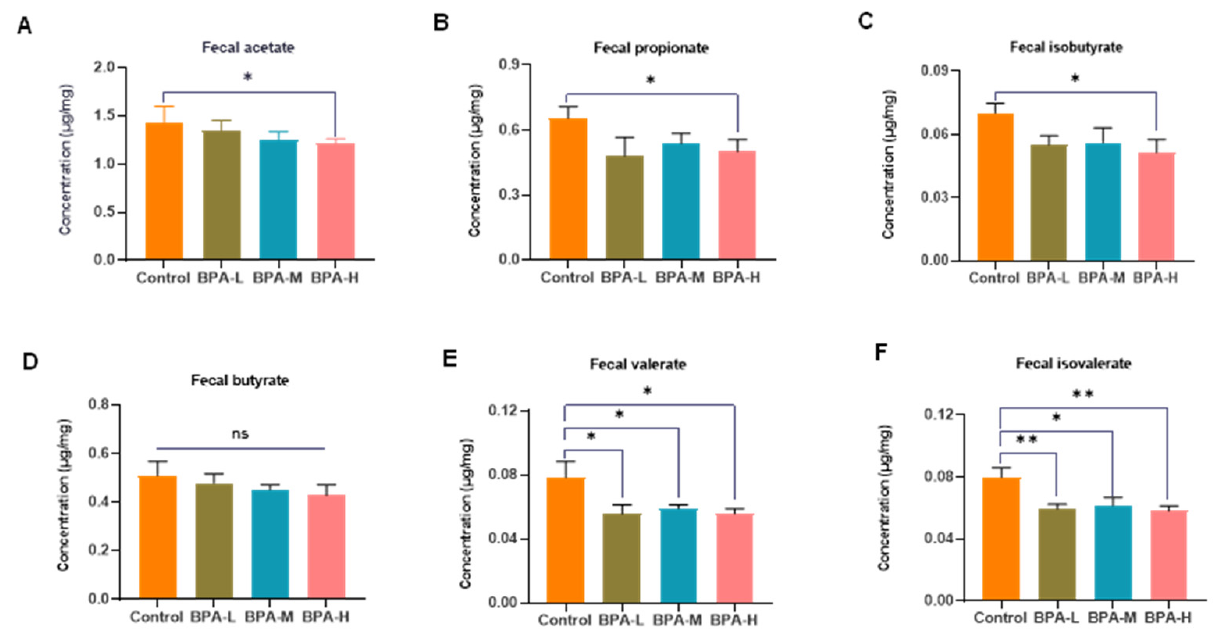
Figure 7. Effects of BPA on the fecal SCFA levels. ( A ) Acetate, ( B ) propionate, ( C ) isobutyrate, ( D ) butyrate, ( E ) valerate, and ( F ) isovalerate. Values were expressed as mean ± SEM in each group ( n = 8). * p <0.05, ** p < 0.01 compared with the Control group. ns: no significance.